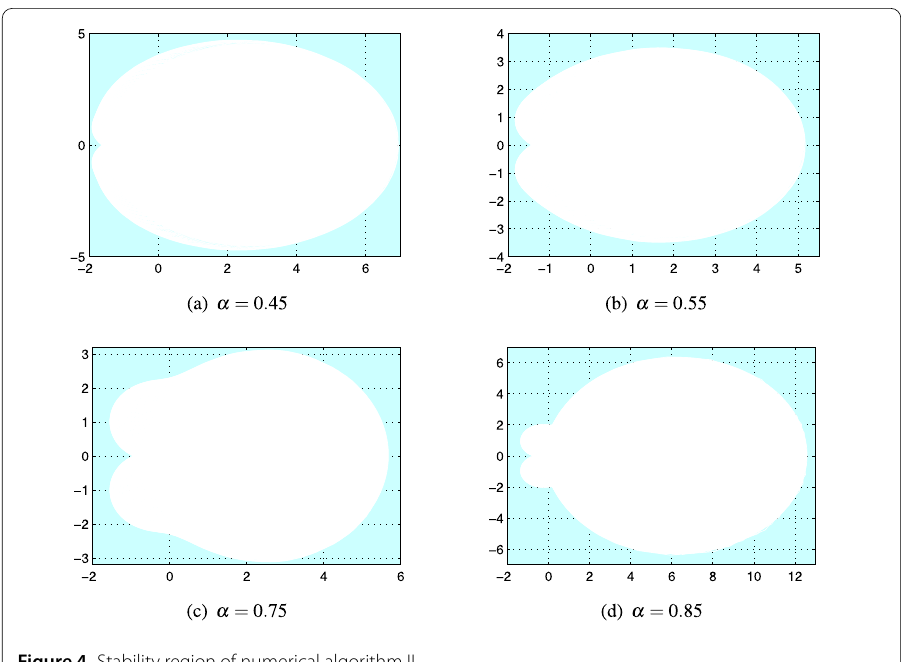
Figure 4 Stability region of numerical algorithm II